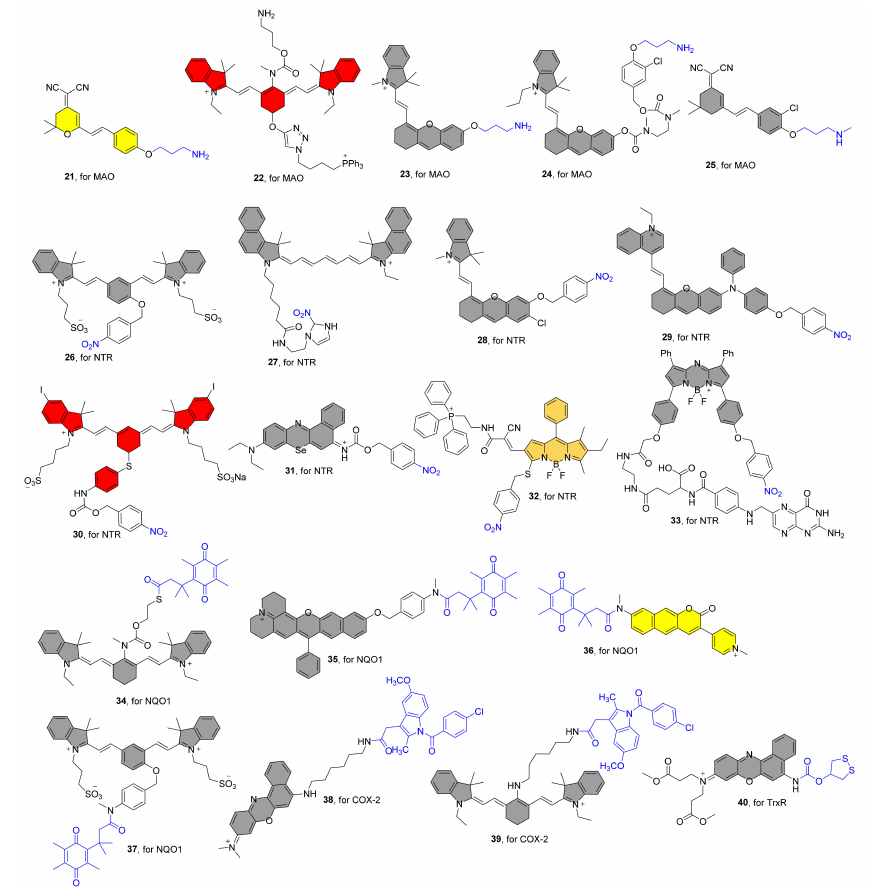
Figure 3. Structures of NIR Fluorescent Probes 21 – 40